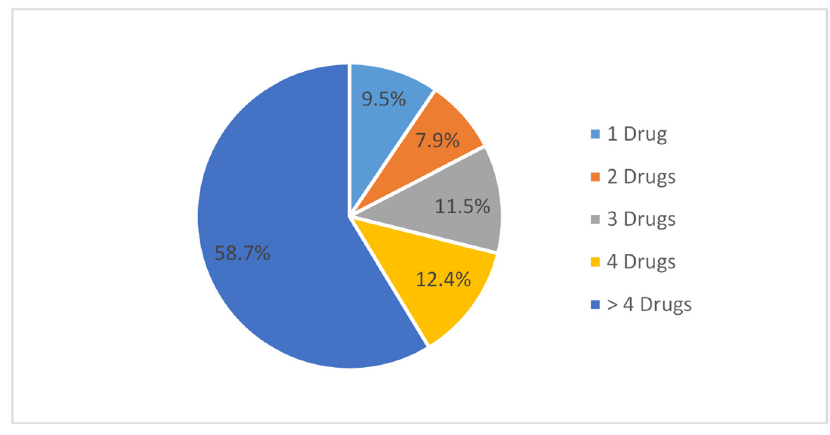
Figure 2. Percentage of the number of drugs prescribed per case.